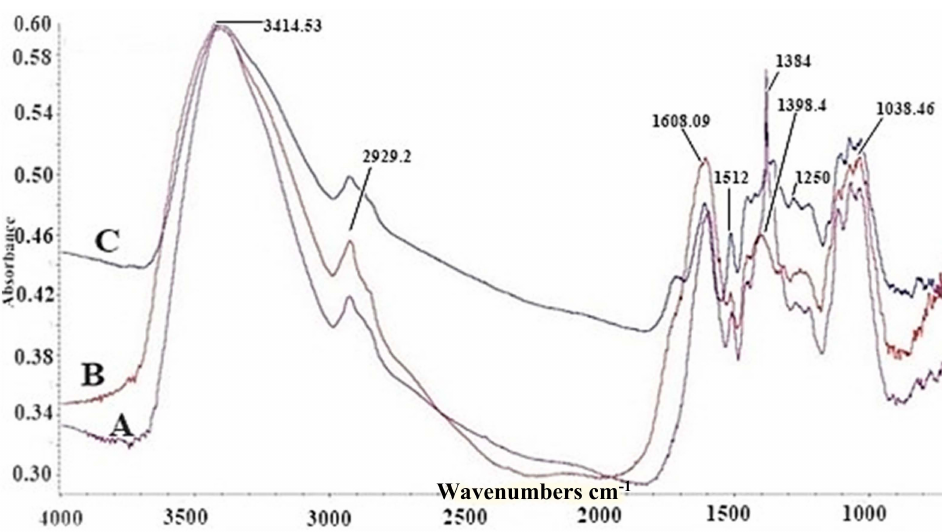
Figure 4. Fourier transform infrared spectra of gold nanoparticles (AgNPs): A—TS2 (AgNPs obtained with AgNO 3 at pH = 9), B—aqueous bark extract, C—TS1 (AgNPs obtained with AgNO 3 at pH =